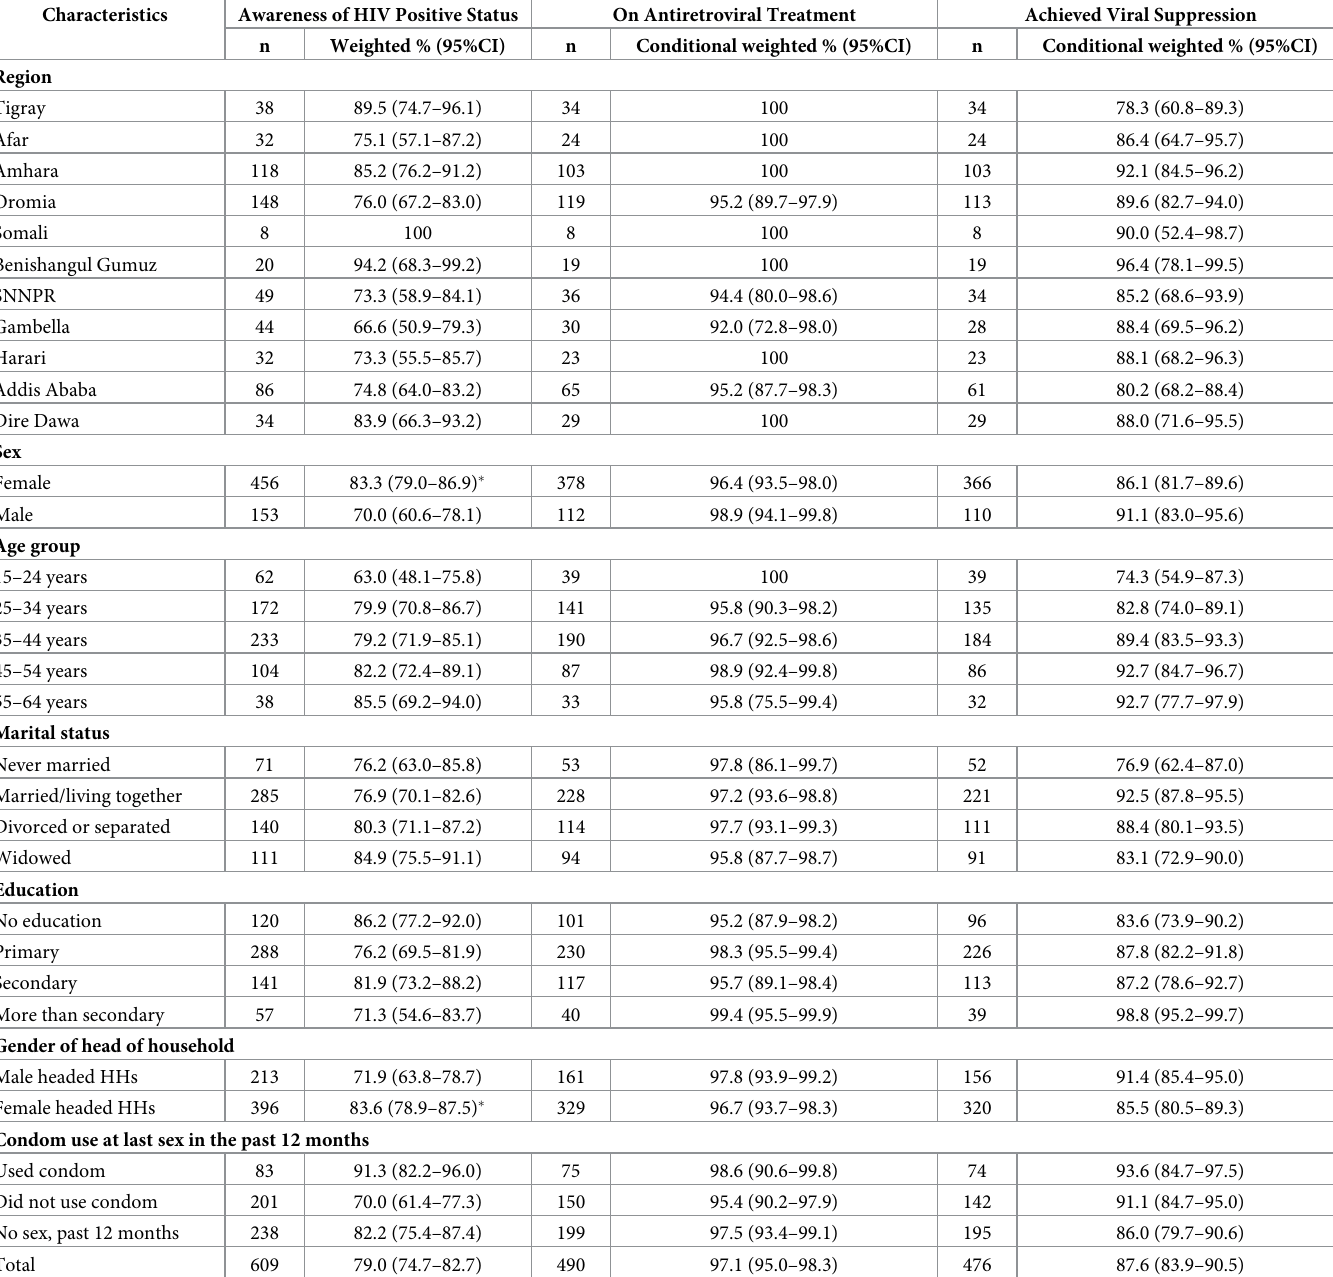
Table 2. Association of socio-demographic and behavioural characteristics with the 90-90-90 targets among participants aged 15–64 years, Ethiopia Population- based HIV impact assessment, 2017–2018.